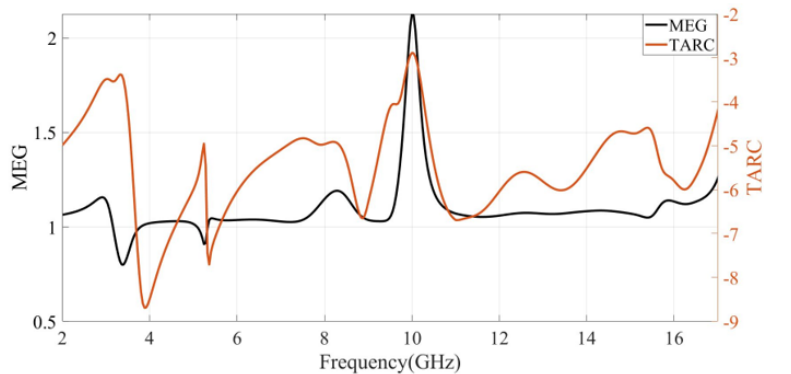
Figure 11. Total active reflection coefficient (TARC) and mean effective gain (MEG) of the proposed MIMO